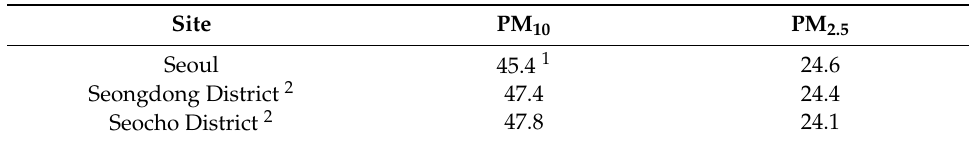
Table 1. Annual averages of airborne PM 10 and PM 2.5 concentrations in Seoul, Seongdong District, and Seocho District during a 5-year period (2013–2017).